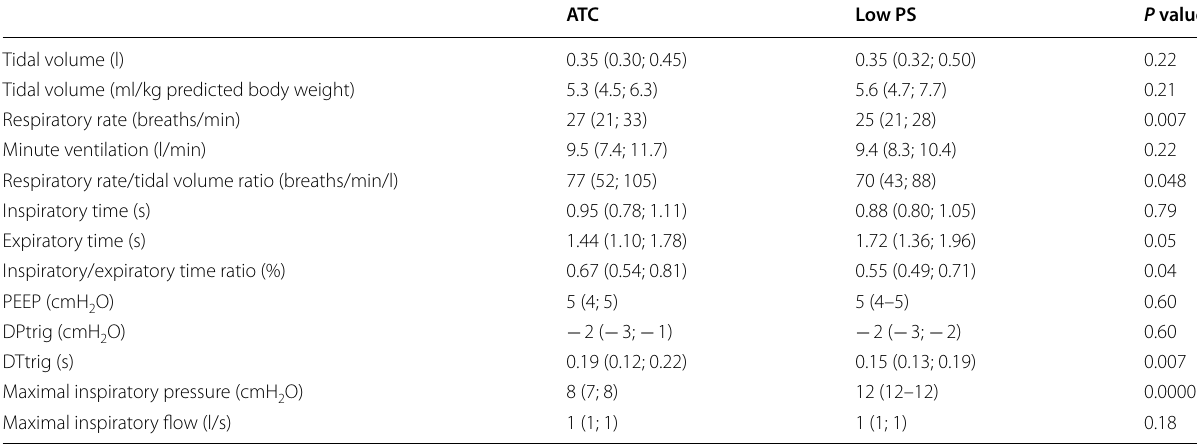
Table 2 Breathing pattern and ventilator functioning in automatic tube compensation and low-pressure support periods during spontaneous breathing trial